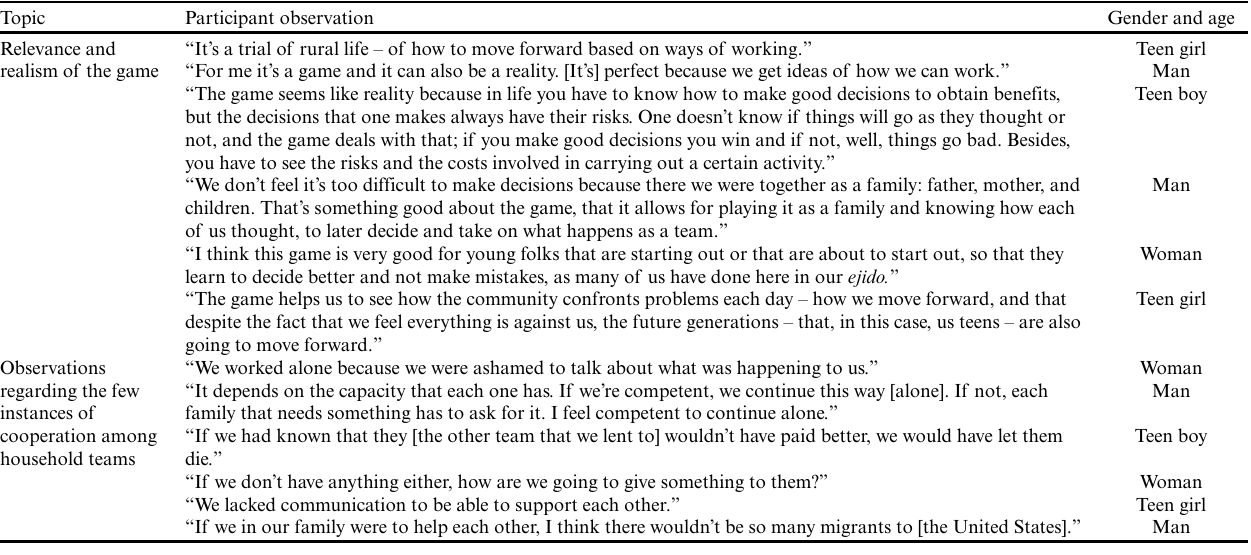
Table 1. Participant comments regarding the relevance of the game to their lives during the single-family session and the few instances of cooperation during the multifamily session.